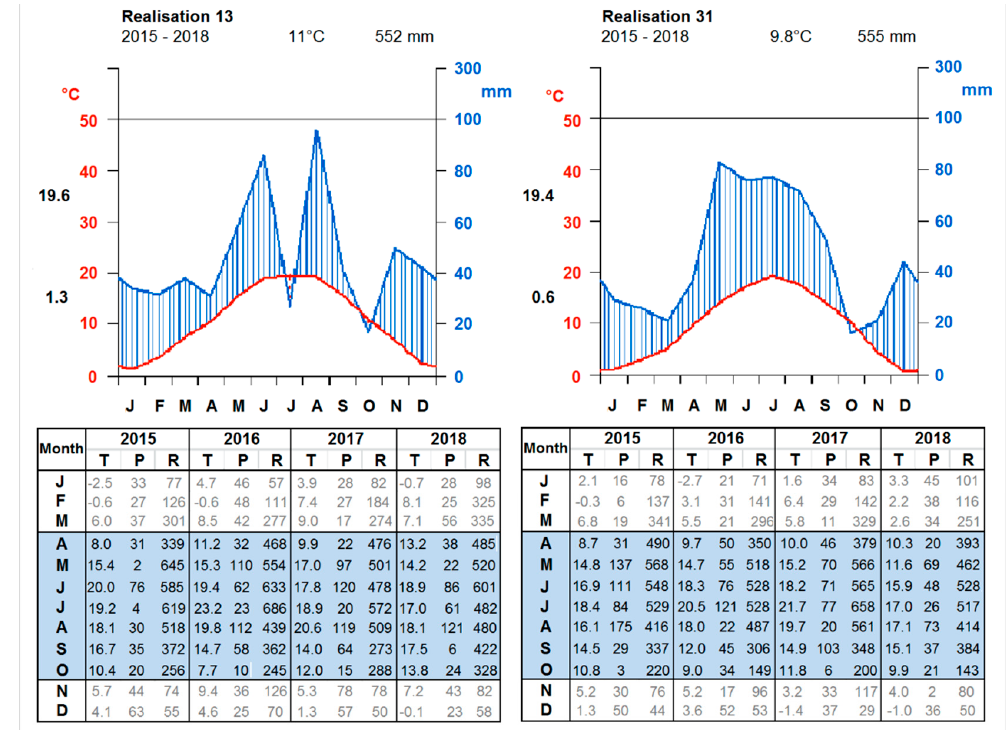
Figure A6. Comparison between realisation 31 and realisation 13 in terms of average monthly air temperature, precipitation and global radiation according to growing period 1 (2015–2018) and with respect to the accumulated biomass obtained by poplar.